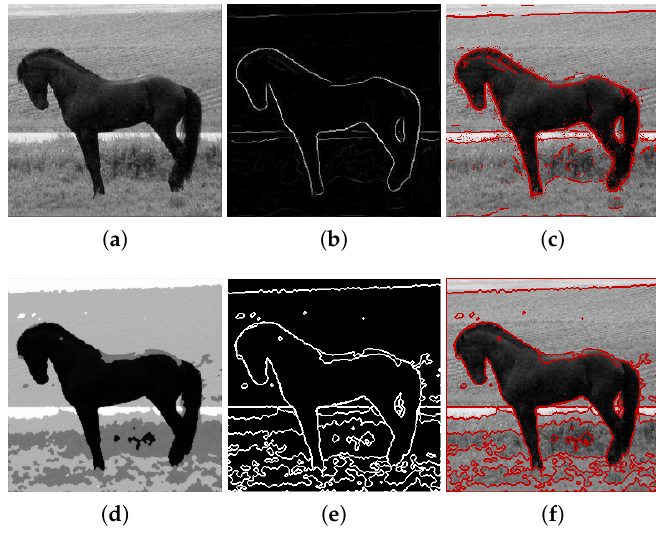
Figure A2. ( a ) Original ‘Horse’ image, ( b ) ground truth boundary information (from [59]), ( c ) images ( a , b ) overlaid, ( d ) our algorithm output, ( e ) boundaries of the segmented regions, ( f ) boundaries for the segmented regions overlaid on the original